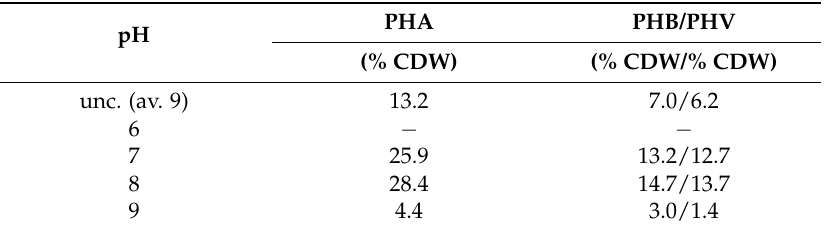
Table 6. PHA production in dependence of the pH.